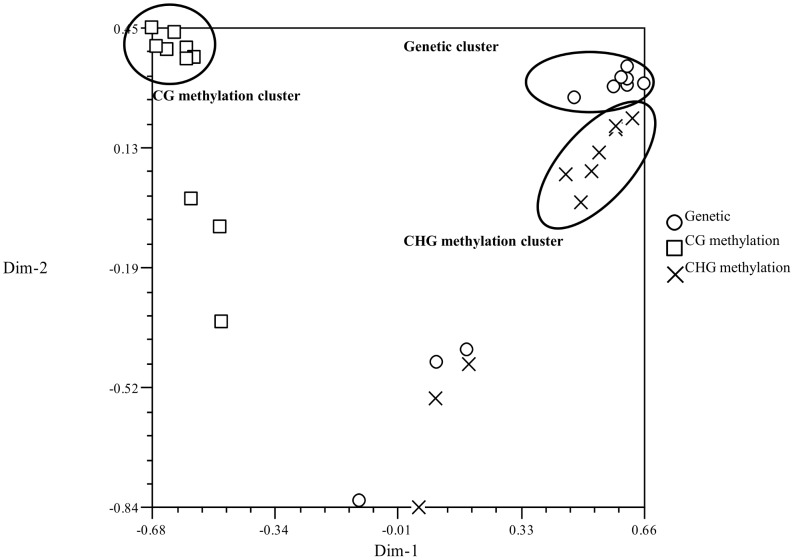
PCA of the ten genotypes for each enzyme combinations plotted in two dimensions.The spatial distance on the graph represents the genetic/DNA methylation relationship between each genotype. Genetic and DNA methylation relationship between the genotypes is more distant between the genetic and DNA methylation state forming genetic, CG methylation, CHG methylation clusters. The CHG methylation and genetic component are closely related, whereas the CG methylation is more distant. The G. barbadense genotypes (CPX12 and Sipima 280) and Coker 315-11 are outliers that are distant from the three clusters, genetically and epigenetically.